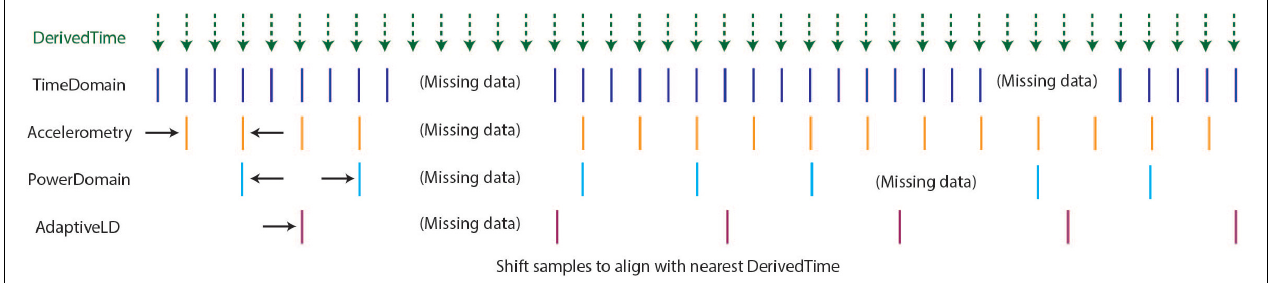
FIGURE 4 | Harmonization of time across data streams to achieve one common DerivedTime timebase. DerivedTime from the time domain is taken as the common time base, as the time domain data have the highest sampling rate. Samples from other data streams are shifted in time slightly to align with the nearest time domain